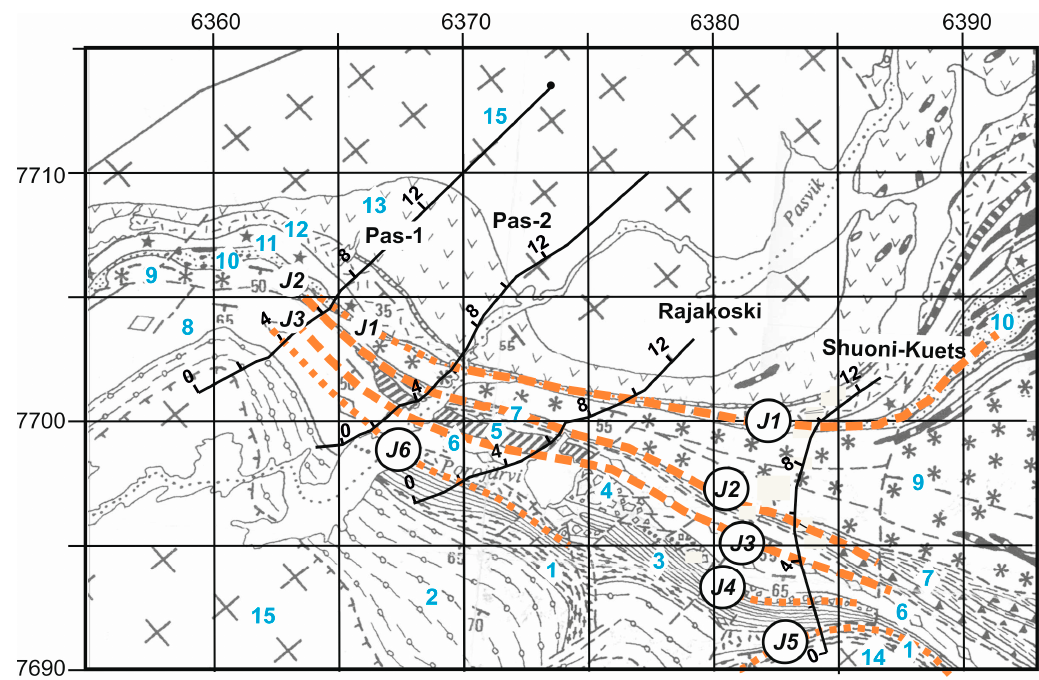
Figure 5. Location of conductive layers J1–J6 on the geological map by V.A. Melezhik [17]. Legend shown by blue figures: South Pechenga (1–8): 1—Pestchanoe Lake (toleit-basalt); 2—Talja (siltstone);